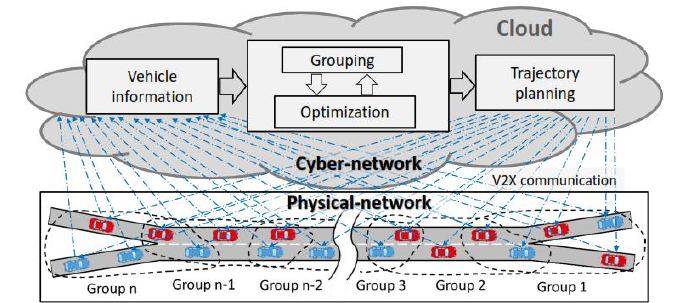
Figure 2. The fundamental idea of our proposed cyber-physical optimal traffic coordinating system. The vehicles are coordinated into groups, and their trajectories are successively optimized.